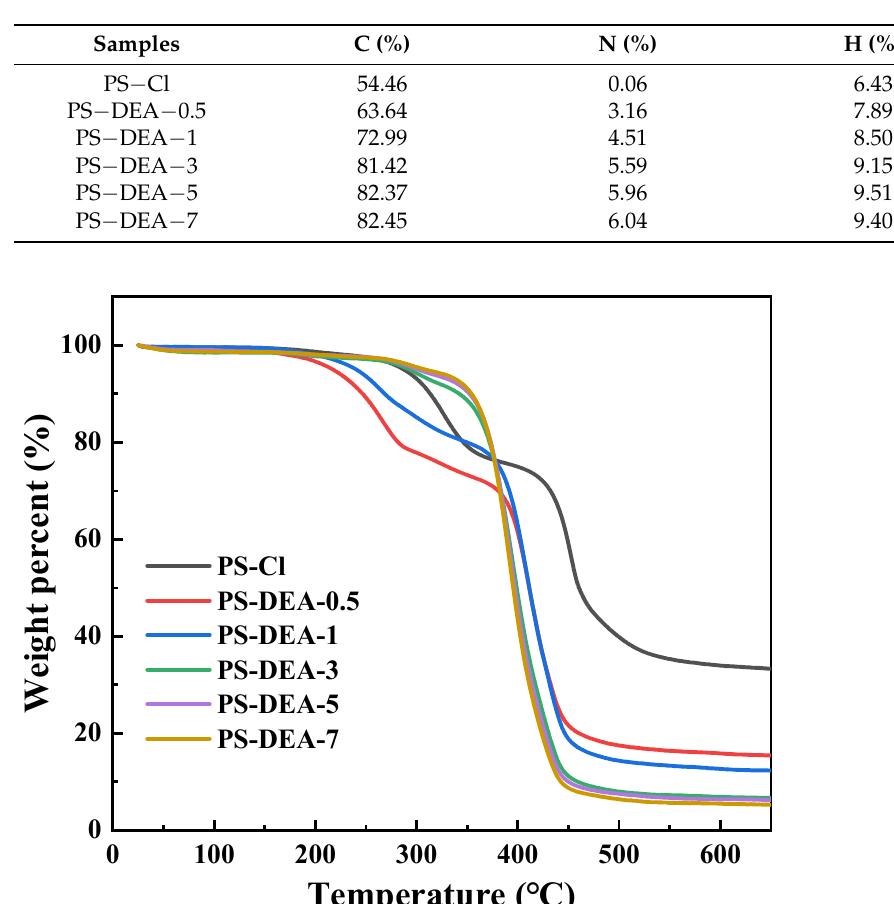
Figure 2. TG analytical curves of PS − DEA −